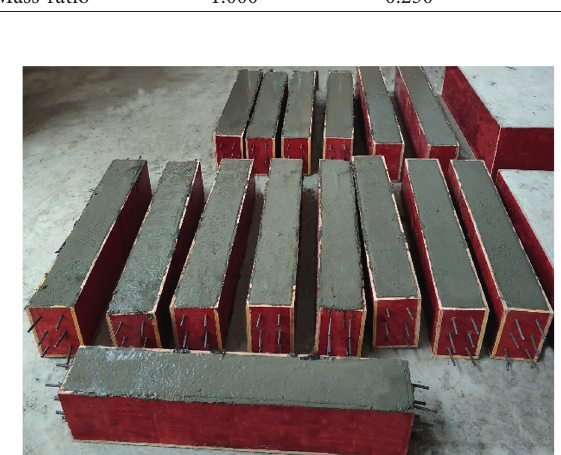
Figure 3: Segment model